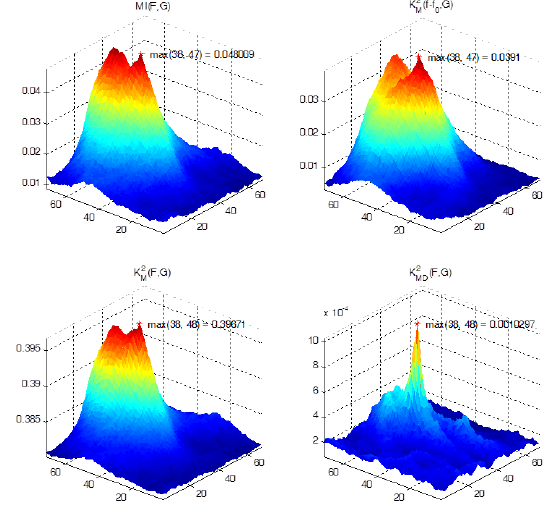
Figure 8. Correlation fields for TV-IR matching (Example 3)